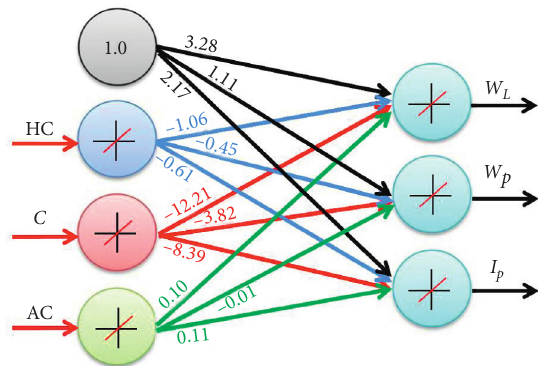
Figure 10: Layout of the developed ANN and its connection